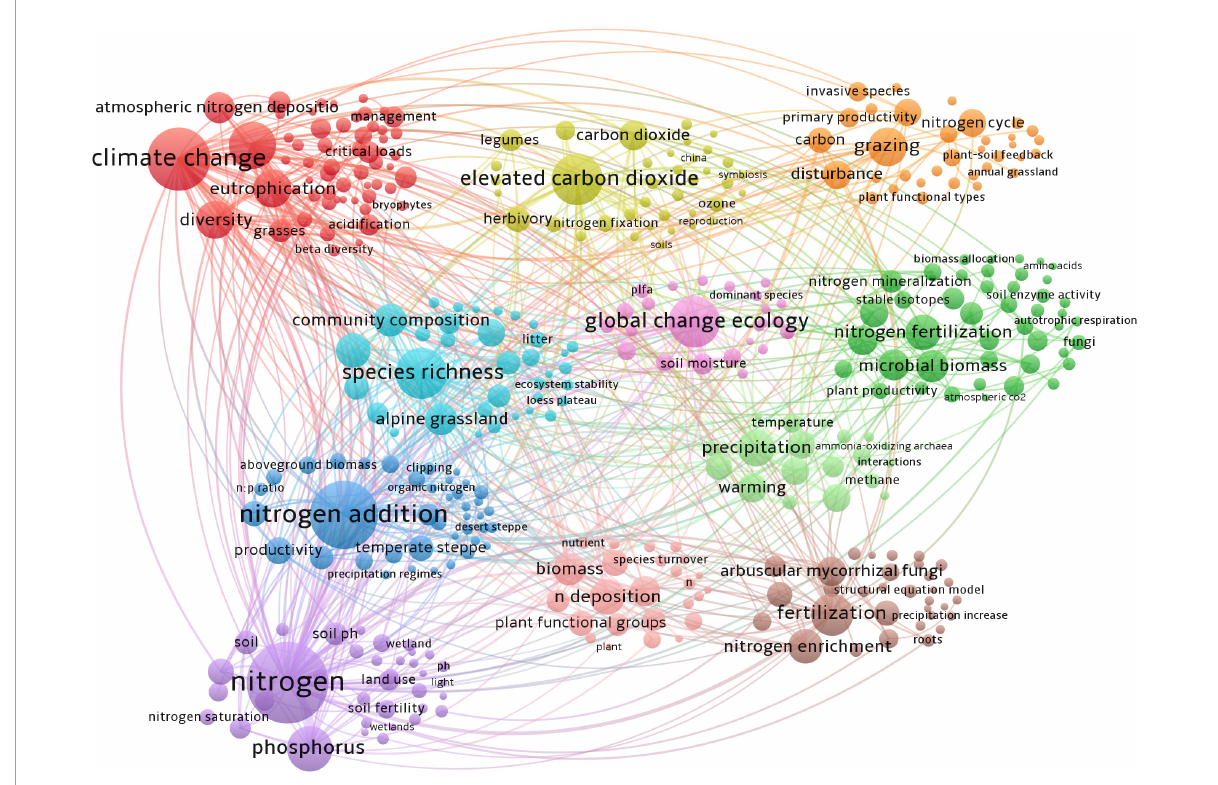
FIGURE3 Network of author keywords based on the co-occurrence method on N deposition research from 1990 to